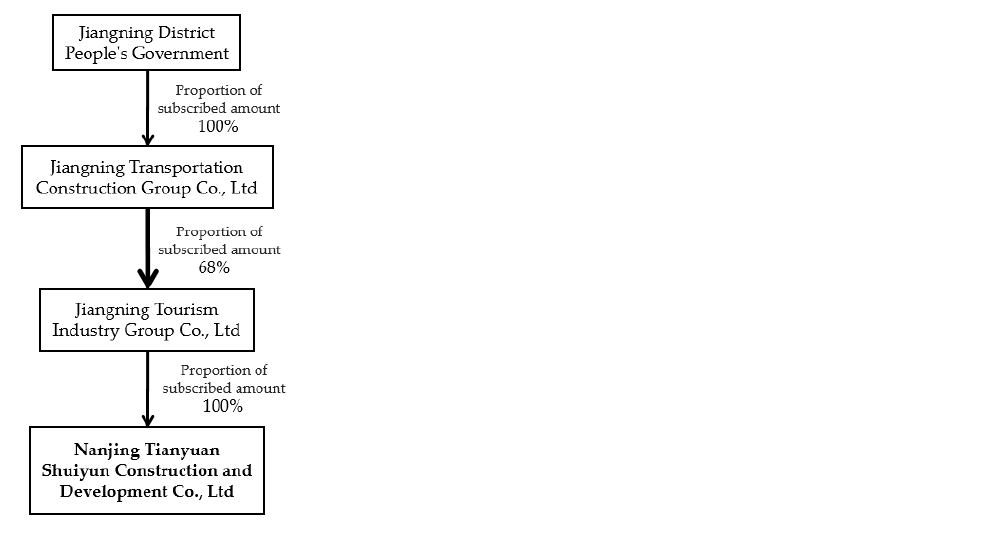
Figure 8. Collective asset management and construction platform at Hushu Subdistrict.